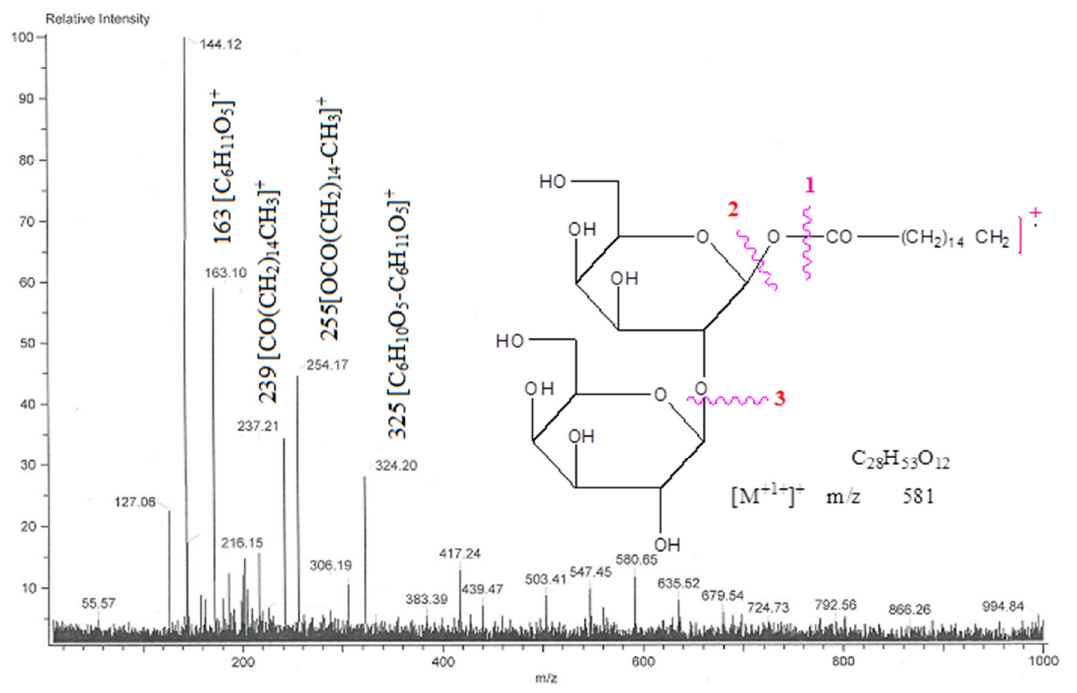
Figure 9. The diagnostic MS/MS fragmentation at m/z 792 full ESI-MS scan of the isolated compound AB-04.